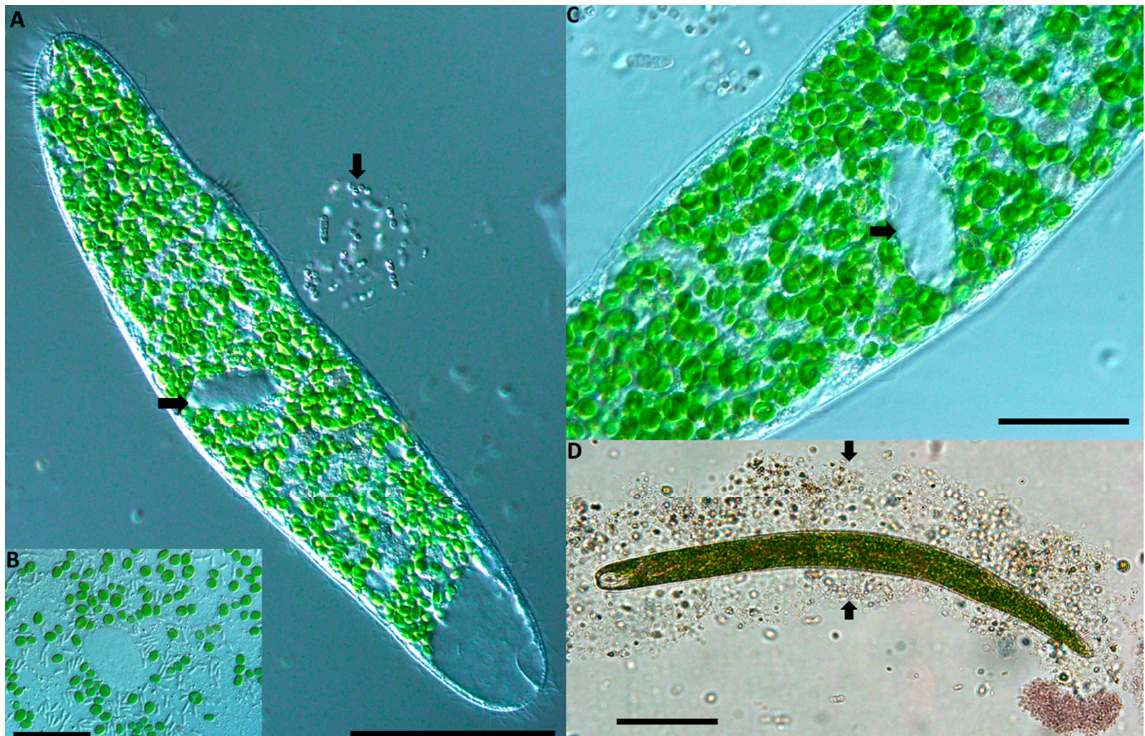
Figure 2. Pseudoblepharisma tenue var. viride from tropical fresh waters in Florida, USA. ( A ) In vivo image of the ciliate showing dense assemblage of symbiotic green algae. The arrow at left indicates the oval macronucleus. The small arrow at right shows a cloud of bacteria which has come off the ciliate, potentially symbiotic in the cytoplasm. The large clear contractile vacuole is conspicuous at the posterior end of the cell (bottom right of image). Scale bar: 100 µm. ( B ) Close-up of the macronucleus (clear oval) surrounded by symbiotic algae resembling Chlorella . Numerous non-pigmented rod-shaped bacteria are also shown here. Scale bar: 20 µm. ( C ) Close-up section of the ciliate with an arrow indicating the singular large oval shaped macronucleus. Directly above the arrow is the small micronucleus. The circular symbiotic algae are densely packed throughout the cytoplasm. Scale bar: 20 µm. ( D ) In vivo image of the ciliate after it was picked and left undisturbed on a slide for ~1 h. The two arrows indicate either side of a casing the ciliate has made and rests entirely within. Scale bar: 100 µm. Table 1. Diagnostic features of the Florida Pseudoblepharisma tenue var. viride representative. Meas- urements were done on 30 freshly collected individual cells.